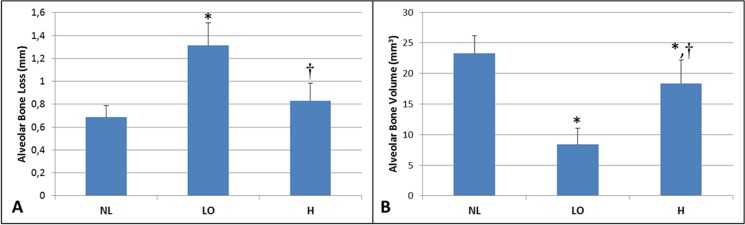
A- Mean ABL in study groups (mm).
B- Alveolar bone volume in study groups (mm3). * Significant difference compared to NL group. † Significant difference compared to LO.